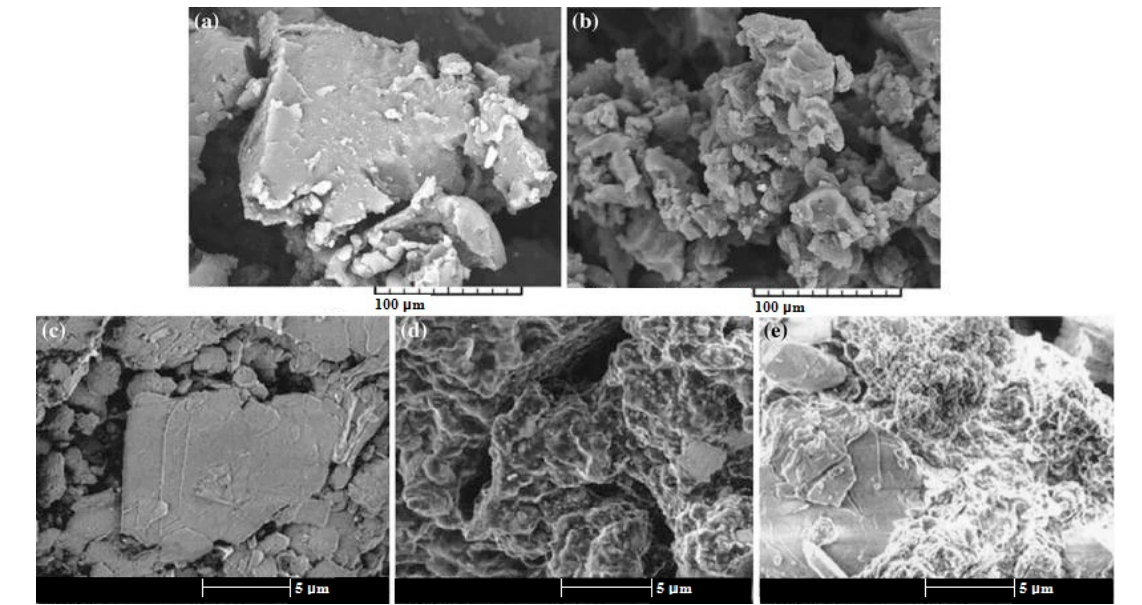
Figure 5. Typical particle surface state for ground tire rubber (GTR) produced from different grinding processes: ( a ) ambient-mechanical, ( b ) water jet, ( c ) cryogenic-pin mill, ( d ) ambient-rotary mill and ( e ) cryogenic-rotary mill (reproduced with permission from [38]).